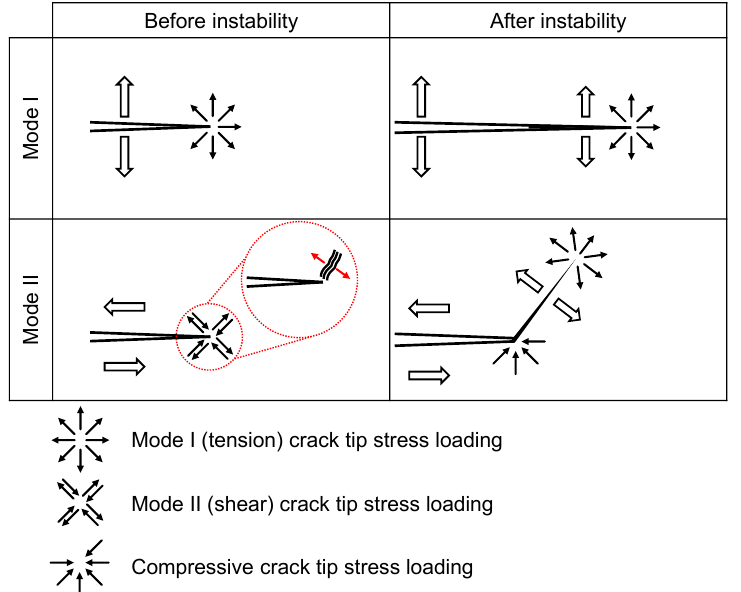
Figure 16. Illustration of crack propagation before and after instability in ( top ) mode I and ( bottom ) mode II with craze initiation at particle adapted from